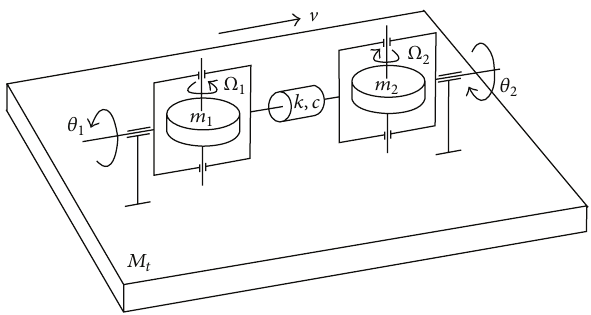
Figure 2: Coupled gyroscopes via a massless torsional spring with stiffness 𝑘 and a massless torsional damper with coefficient 𝑐 .